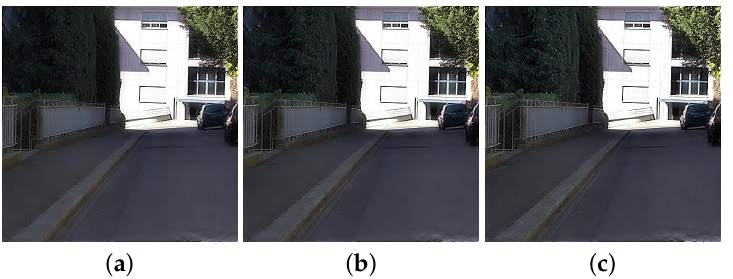
Figure 6. Color enhancement results with ( a ) β = 0.6, ( b ) β = 0.8, and ( c ) β = 1.0.